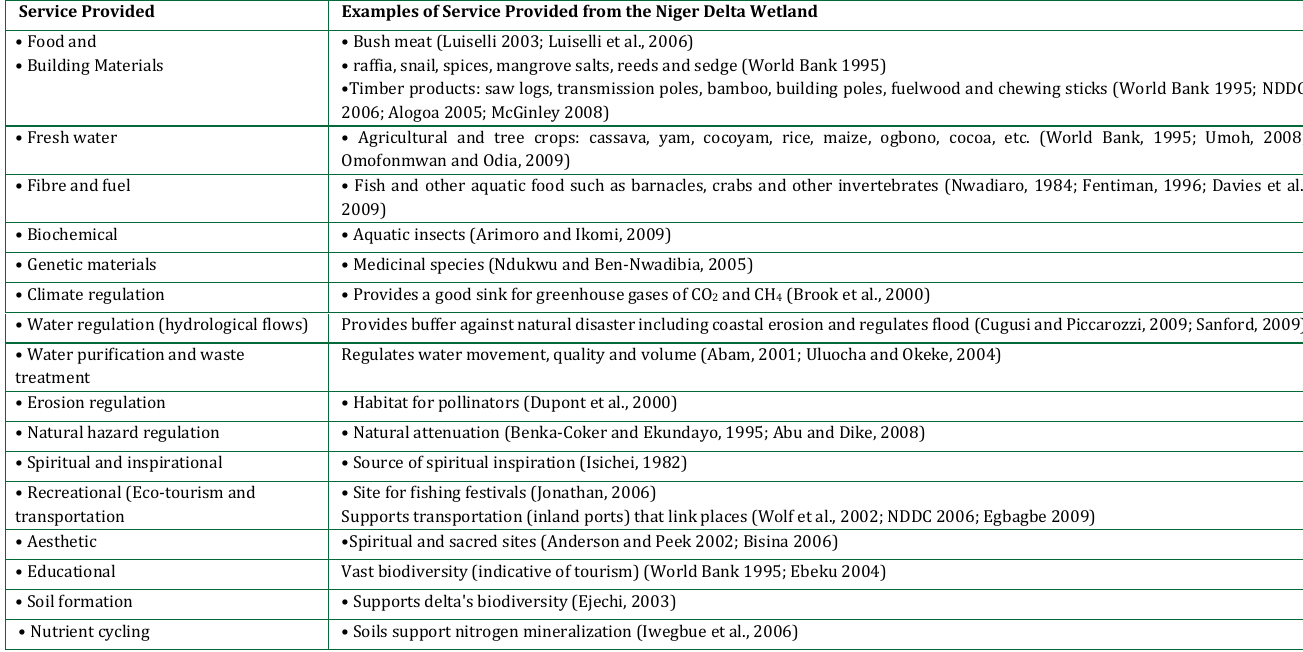
Table 2: Major ecosystem services provided by or derived from Niger Delta